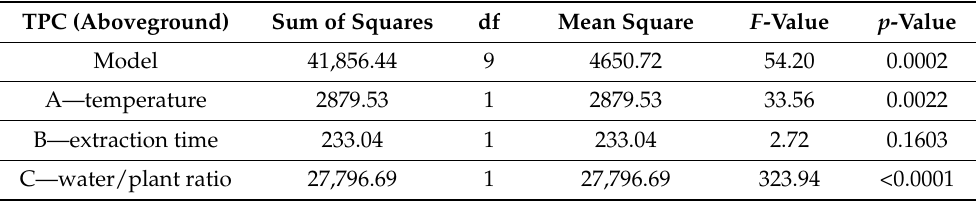
Table 3. Variance analysis for the total phenol contents of the aboveground part and roots of O. mutabilis